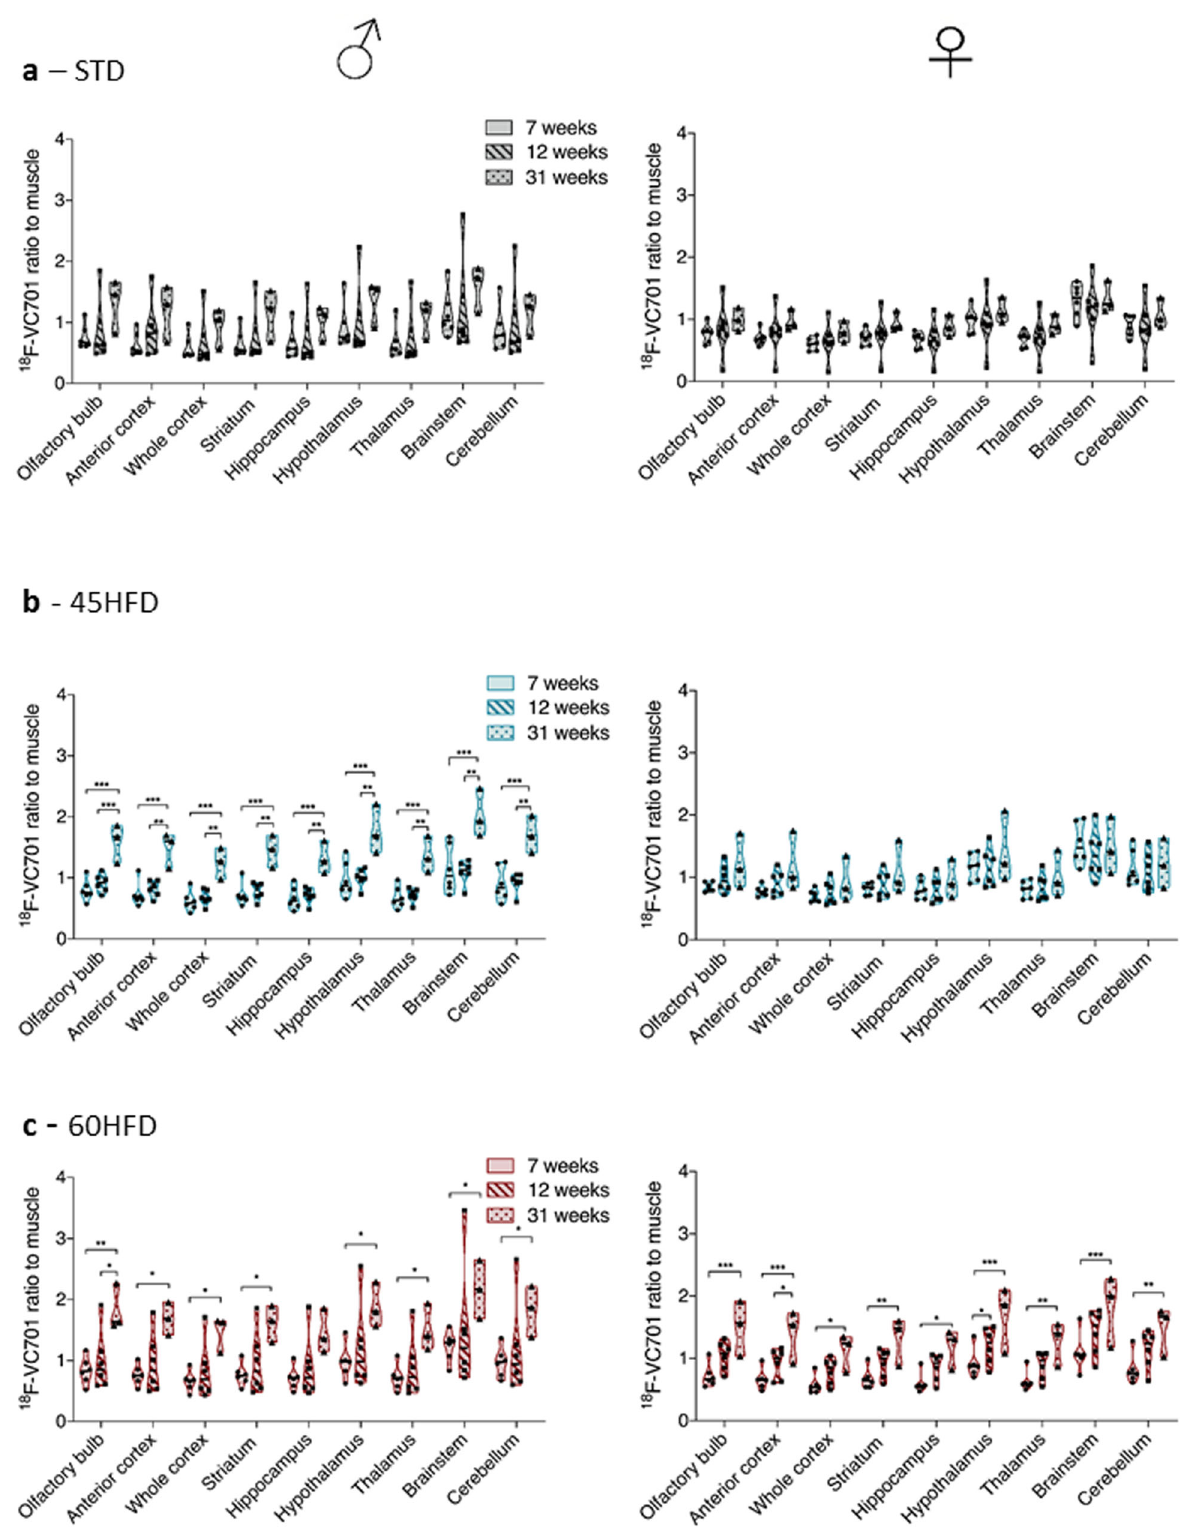
Fig. 3 Longitudinal [ 18 F]-VC701 uptake ratio of different brain regions in male (left panels) and female (right panels) mice at 7, 12, and 31 weeks of diet. a STD (control diet), b 45% HFD (45HFD), c 60% HFD (60HFD). Data are expressed as mean ± SD of ratio to muscle radiotracer uptake. All data were analyzed using two-way ANOVA in which within each row, each column mean was compared, followed by Tukey ’ s post hoc test for multiple comparison (* p ≤ 0.05; ** p ≤ 0.01; *** p ≤